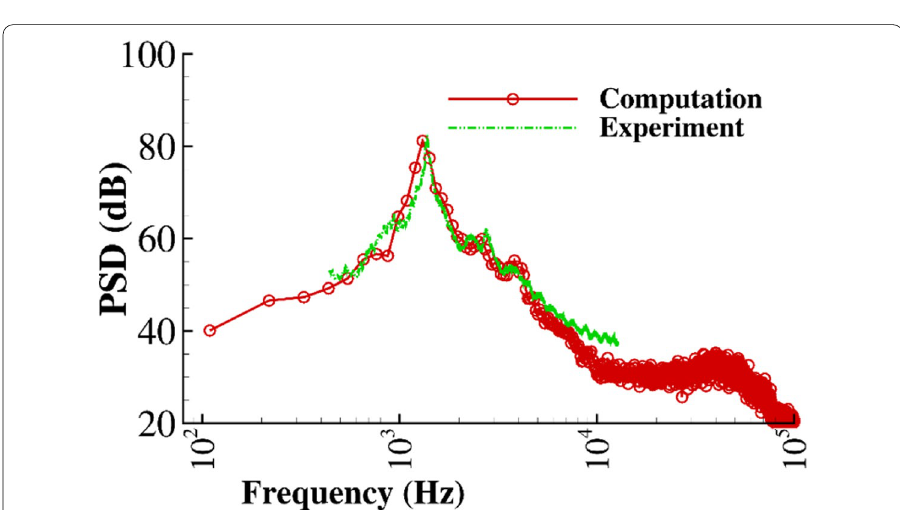
Fig. 18 Comparison of sound pressure spectra at r